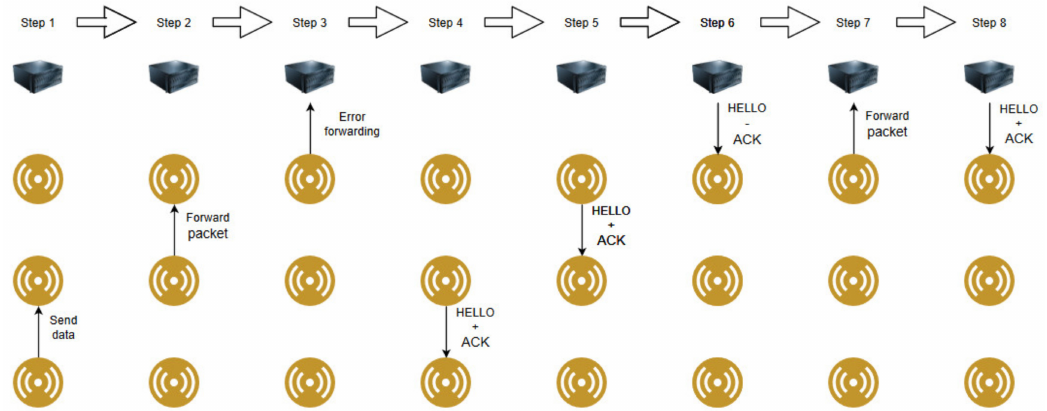
Figure 6. Flow of operations in the resend case when packet loss